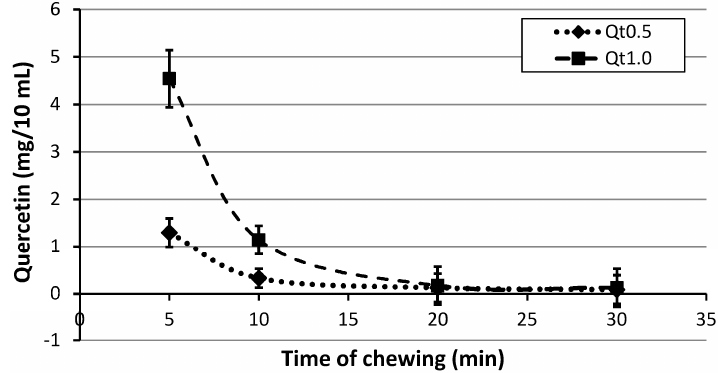
Figure 3. In vivo release of quercetin (mean ± S.D.) from different gum formulations by a chew-out study performed by 32 participants (three samples for each participant, for two experiments) over a 30 min period. Saliva was collected at 5, 10, 20, and 30 min.